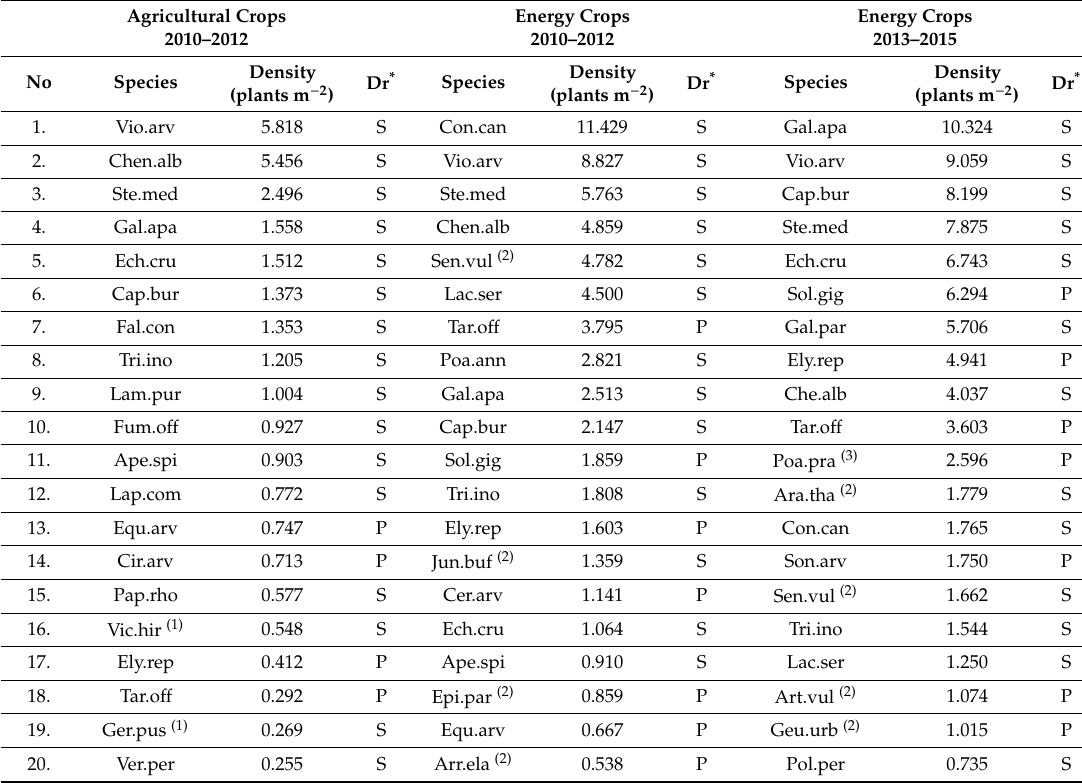
Table 3. List of species and mean density of weed flora accompanying annual agricultural crops and crops for energy